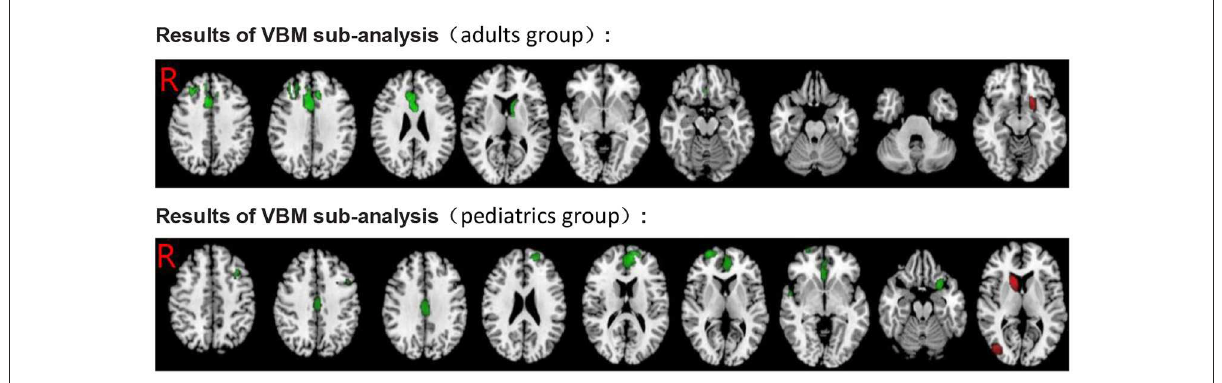
FIGURE4 Results of subgroup analysis of VBM for ADHD. Green, GMV decreased in ADHD; Red, GMV increased in ADHD.